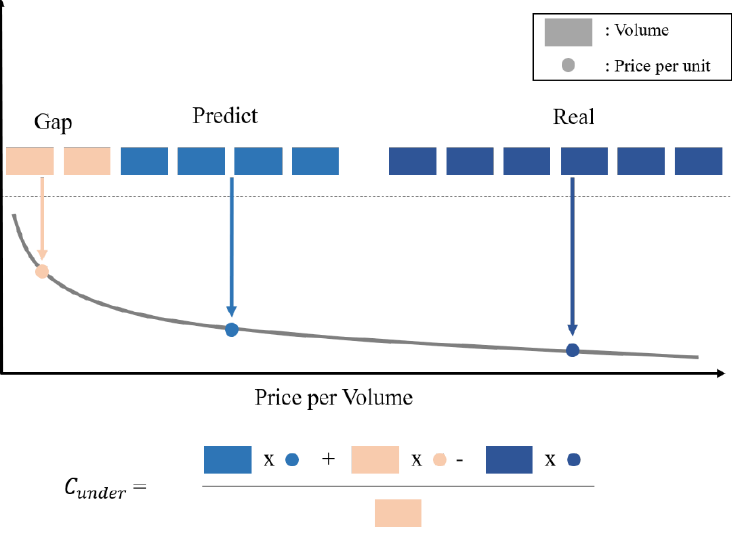
Figure 10. Calculating the underestimation cost.